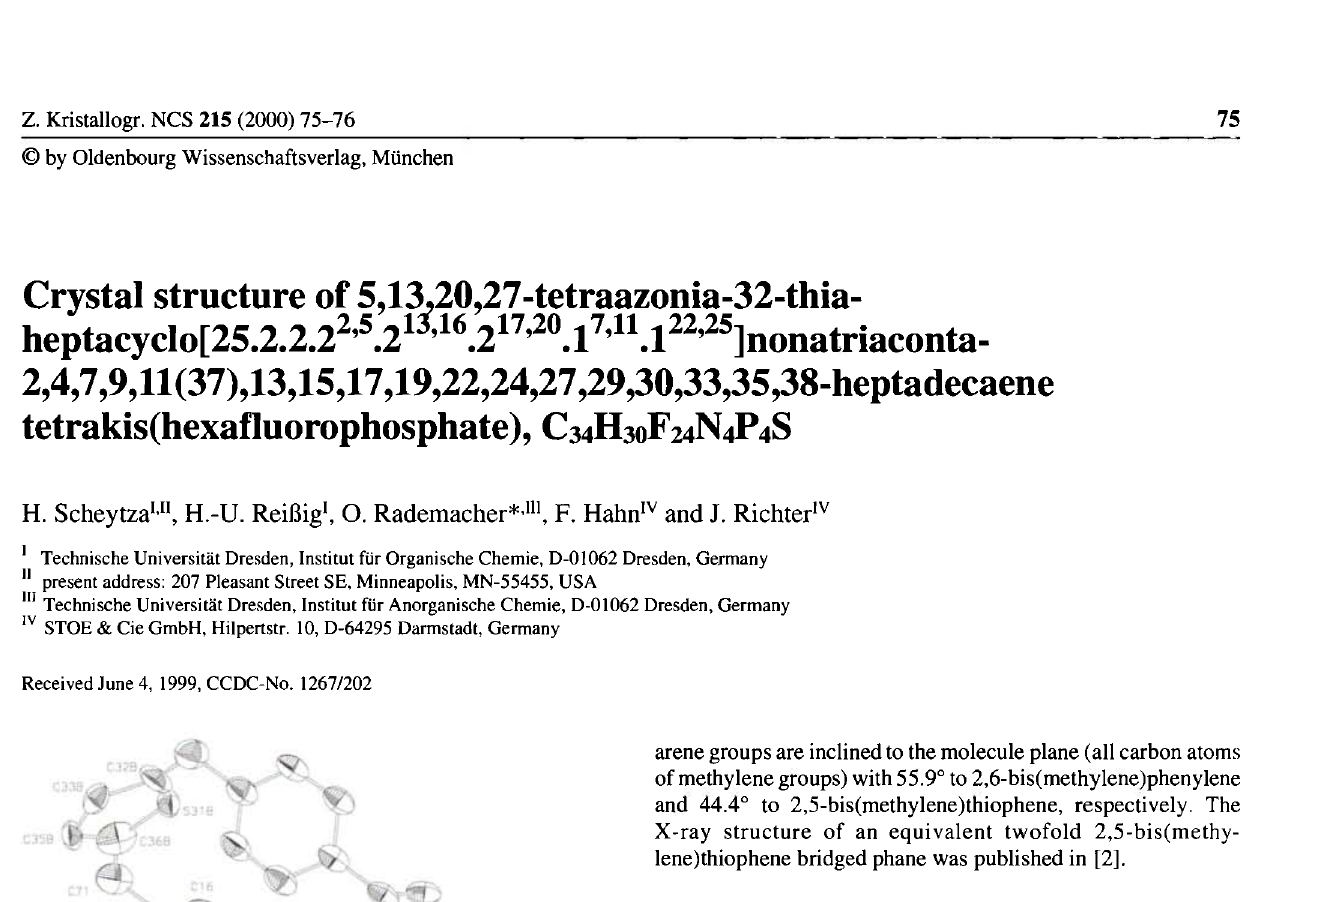
Table 1. Data collection and handling. Crystal: